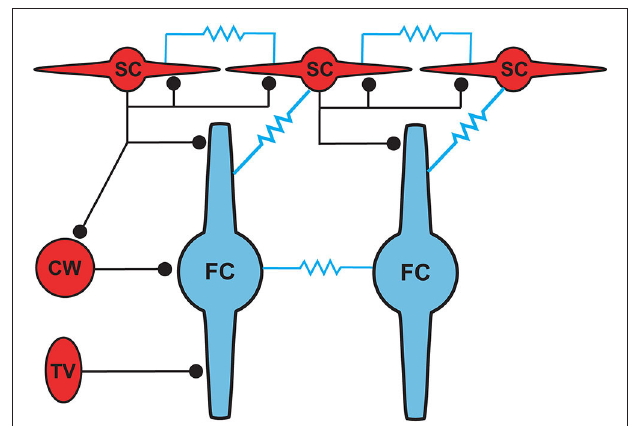
FIGURE 5 | Proposed circuit diagram for inhibitory inputs to fusiform cells and the gap junction connectivity (represented by resistors) between SSCs and fusiform cells . SSCs, cartwheel and tuberculoventral cells occupy distinct domains of the fusiform somatodendritic space. SSCs are unique among the three inhibitory cell types in their additional electrical connectivity with fusiform cells and with one